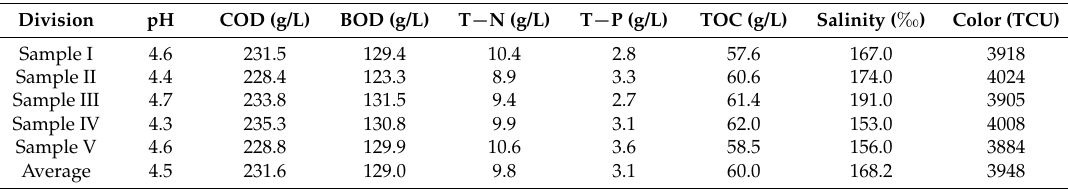
Table 4. Characteristics of waste soy sauce.